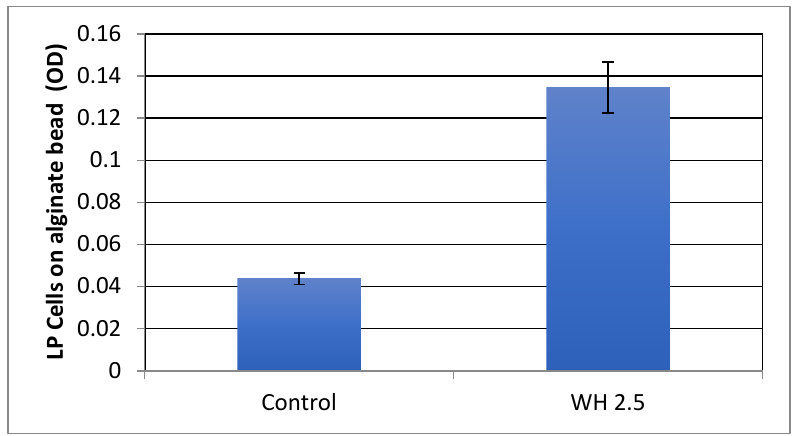
Figure 5. The effect of witch hazel (WH) on biofilm formation by L . plantarum on alginate beads. Bacteria were incubated with alginate beads in the presence of WH diluted 1:80 (WH 2.5) or ethanol control and the OD of adherent bacteria was determined.